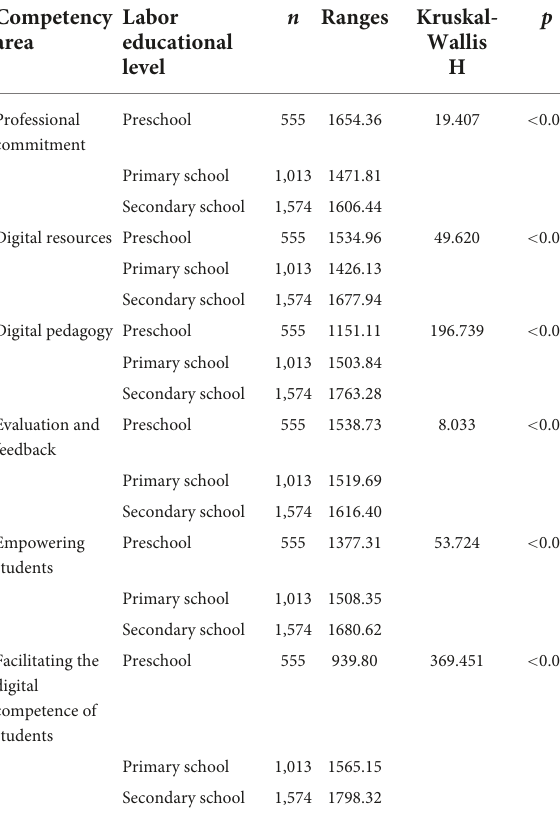
TABLE 6 Kruskal-Wallis H results for the areas of digital teaching competence according to labor educational